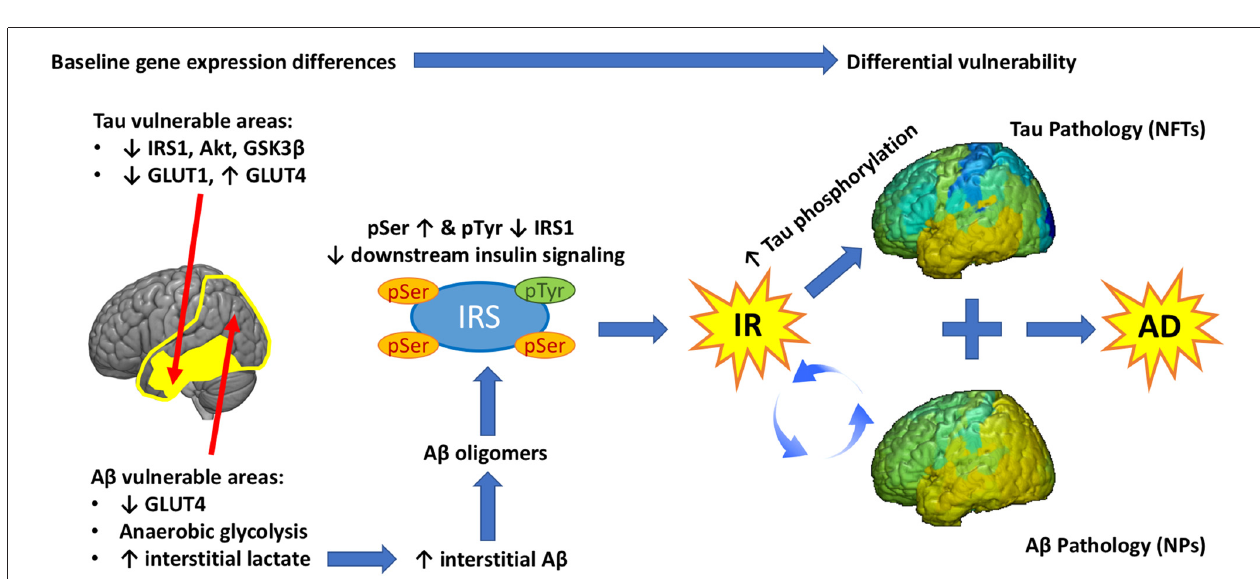
FIGURE 3 | (A) Precuneal voxel placement for the junctional point-resolved spectroscopy (J-PRESS) acquisition is shown in red (25 × 18 × 20 mm 3 ) within a 3D brain cutaway image (figure created in MRIcroGL version 1.150909). (B) Sample 2D J-PRESS spectral fitting from a representative 48-year-old male cognitively normal (CN) participant. (C) Scatter plot of the correlation between the Glc/Cr and fasting Glucose values in 15 healthy male participants (red squares).